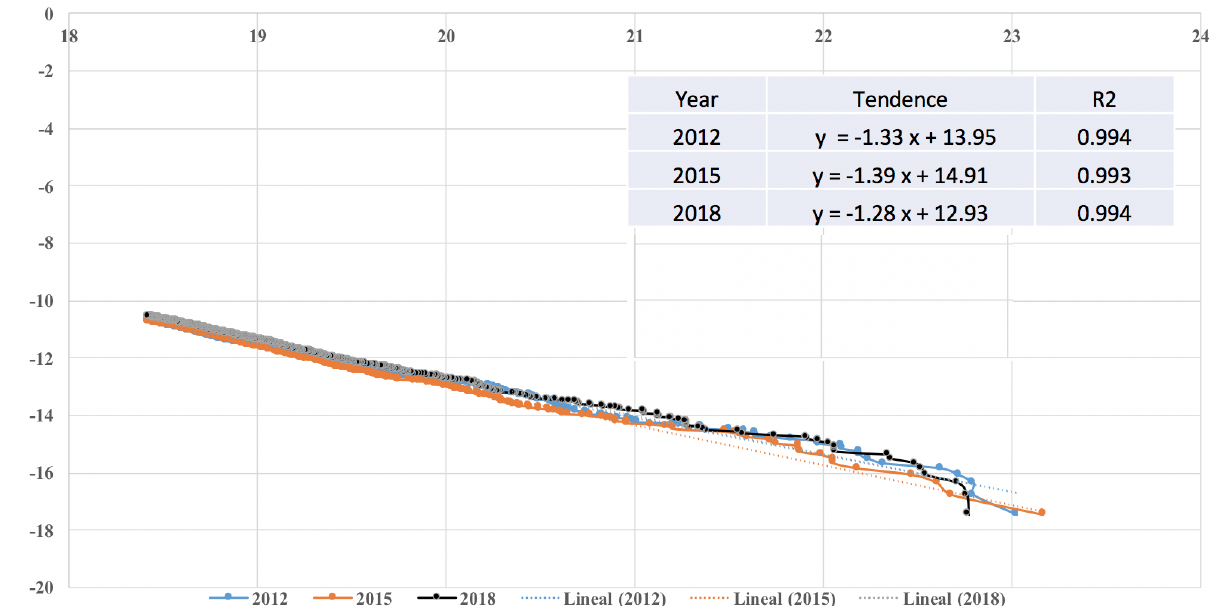
Figure 8. Evolution of the top wealth interval of over time.